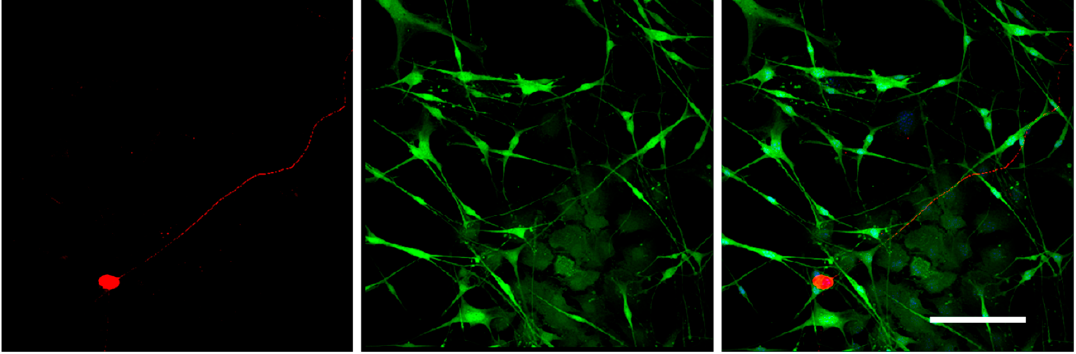
Figure 8. Immunofluorescent staining of the primary cell culture derived from mouse DRGs after 3